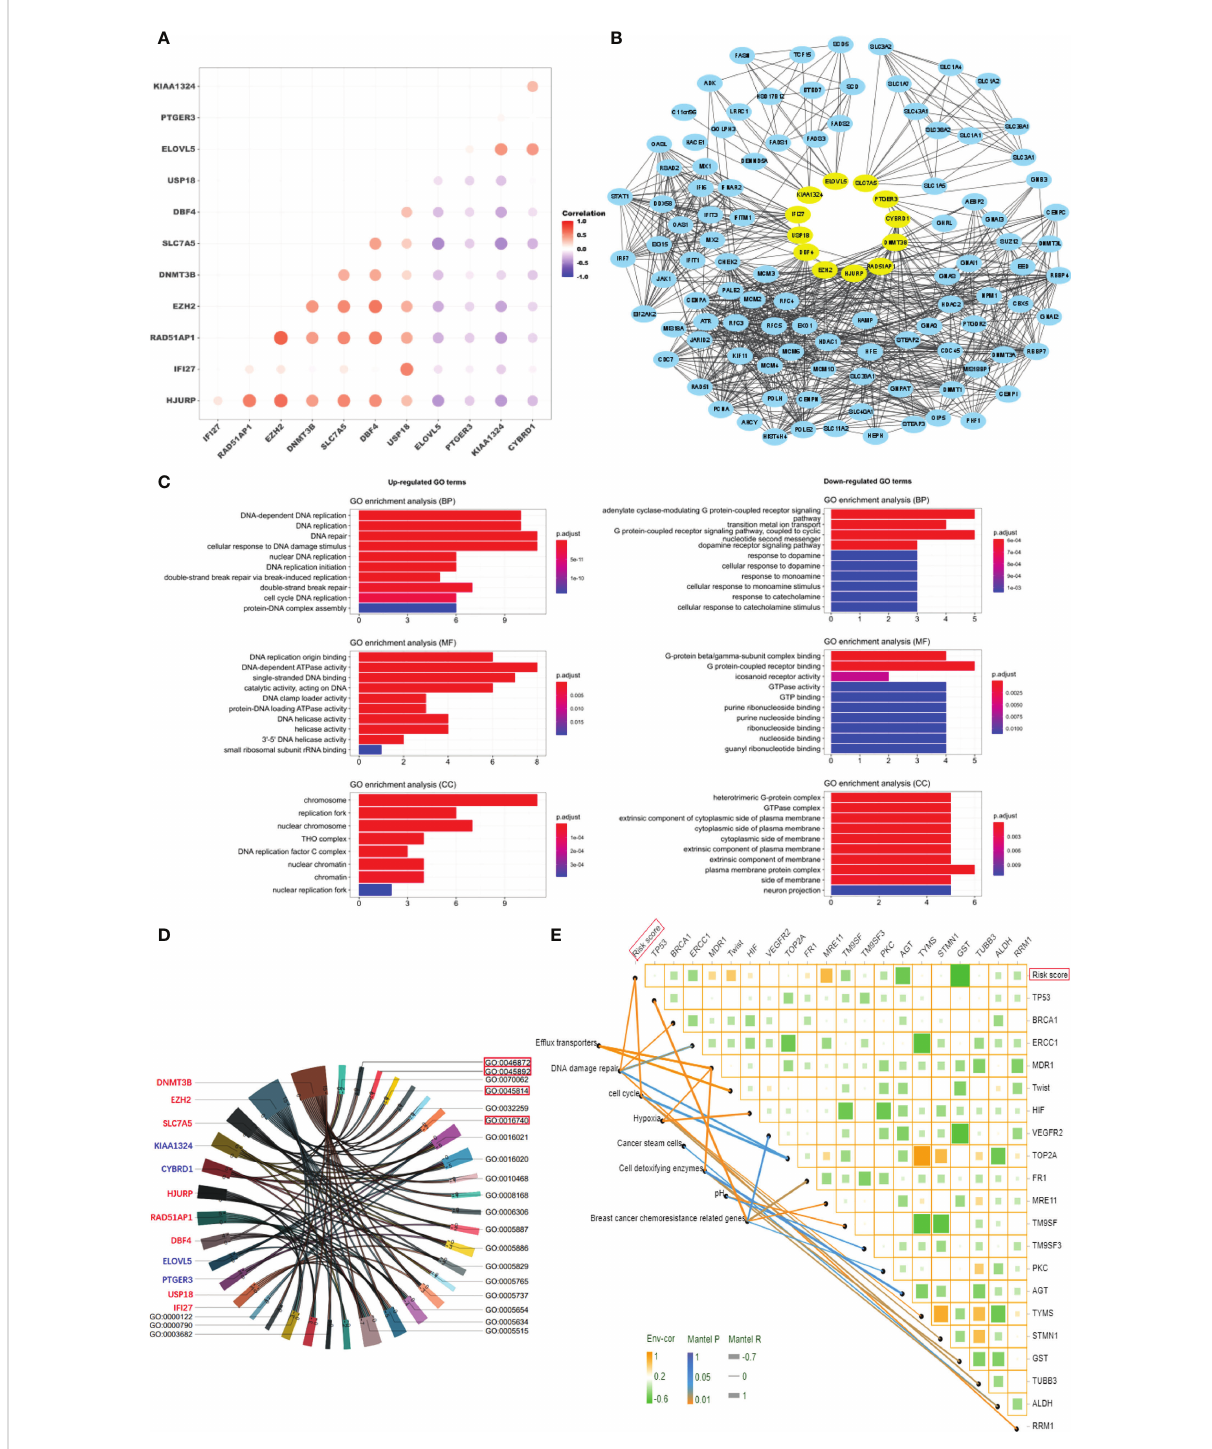
FIGURE 4 Characteristics of tumor cells in high-risk patients. (A) Correlation analysis of the expression of 12 genes. (B) Protein network interaction map for the 12 genes. (C) GO enrichment analysis of the 12 genes (P < 0.01). (D) Chord plot of interaction between the 12 genes and GO enrichment terms. (E) The correlation analysis of risk score and gene expression in breast cancer resistance-related